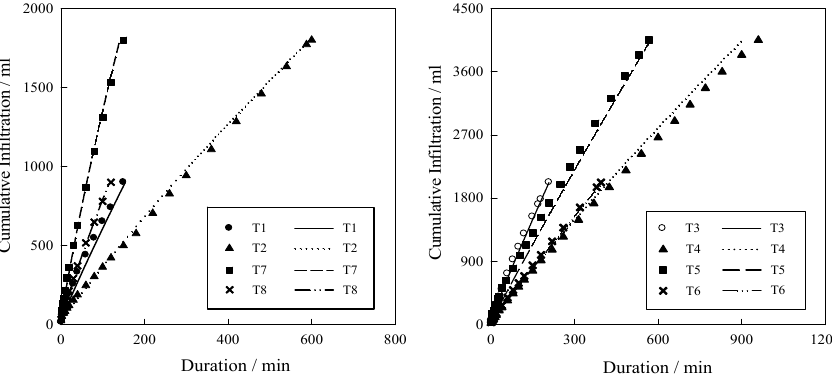
Figure 5. Comparison of simulated and measured values of cumulative infiltration under different treatments (cumulative infiltration represents the irrigation volume of the controlling area of a single hole in the experimental setup (see Figure 1); measured values are represented by dots, whereas simulated values are represented by lines).